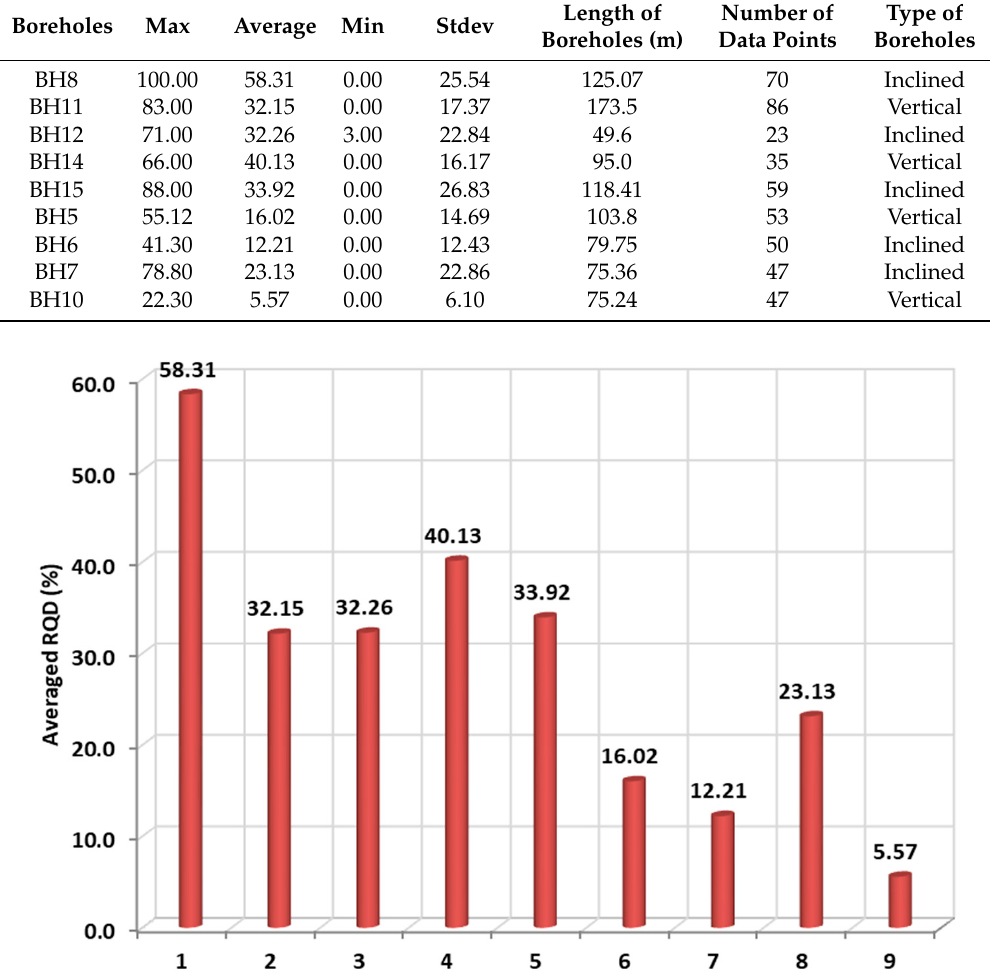
Table 1. Statistical description of RQD for each borehole.